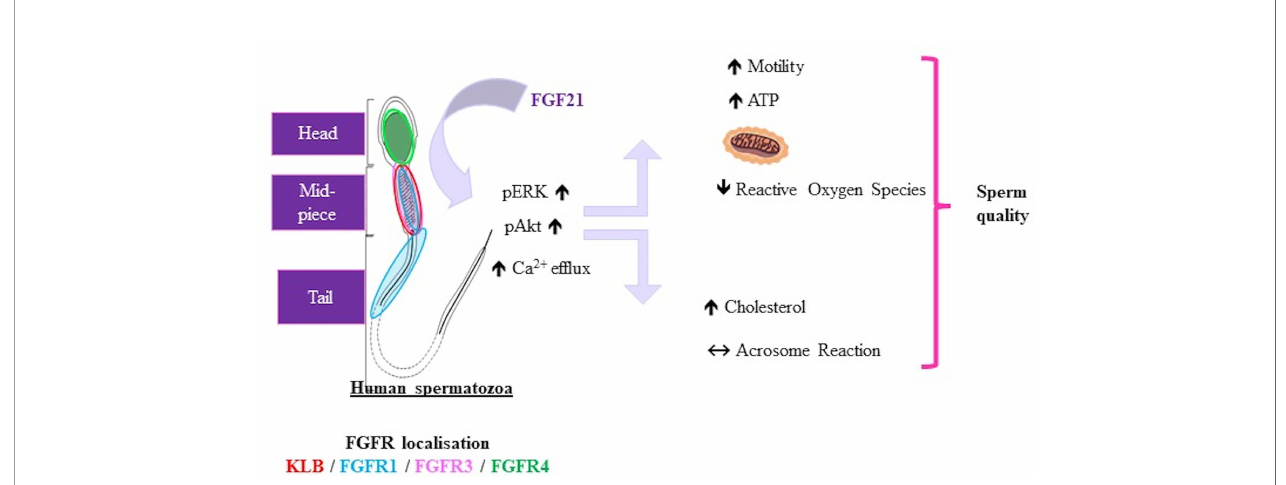
FIGURE 6 | Representative schema of FGF21 effects on human spermatozoa. Representative schema of the localization of FGFRs and KLB in spermatozoa and effects of FGF21 on human sperm. FGF21 induced phosphorylation of the Akt and ERK pathways and calcium levels, then increased the sperm motility associated with ATP content in a dose-dependent manner, and reduced oxidative